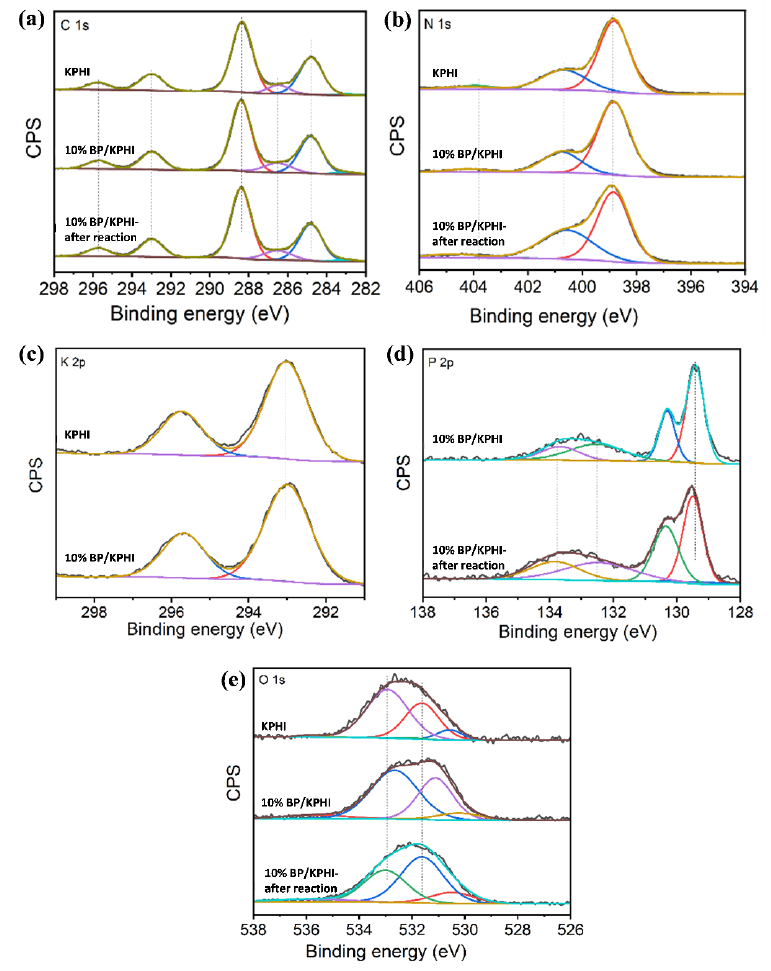
Figure 6. XPS spectra of ( a ) C 1s , ( b ) N 1s, ( c ) K 2p, ( d ) P 2p, and ( e ) O 1s for 10%